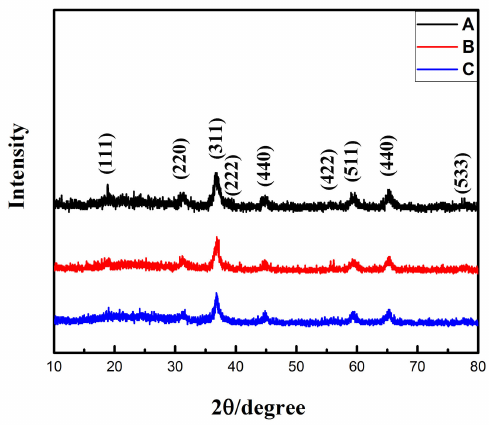
Figure 2. XRD pattern of A, B and C Co 3 O 4 electrode